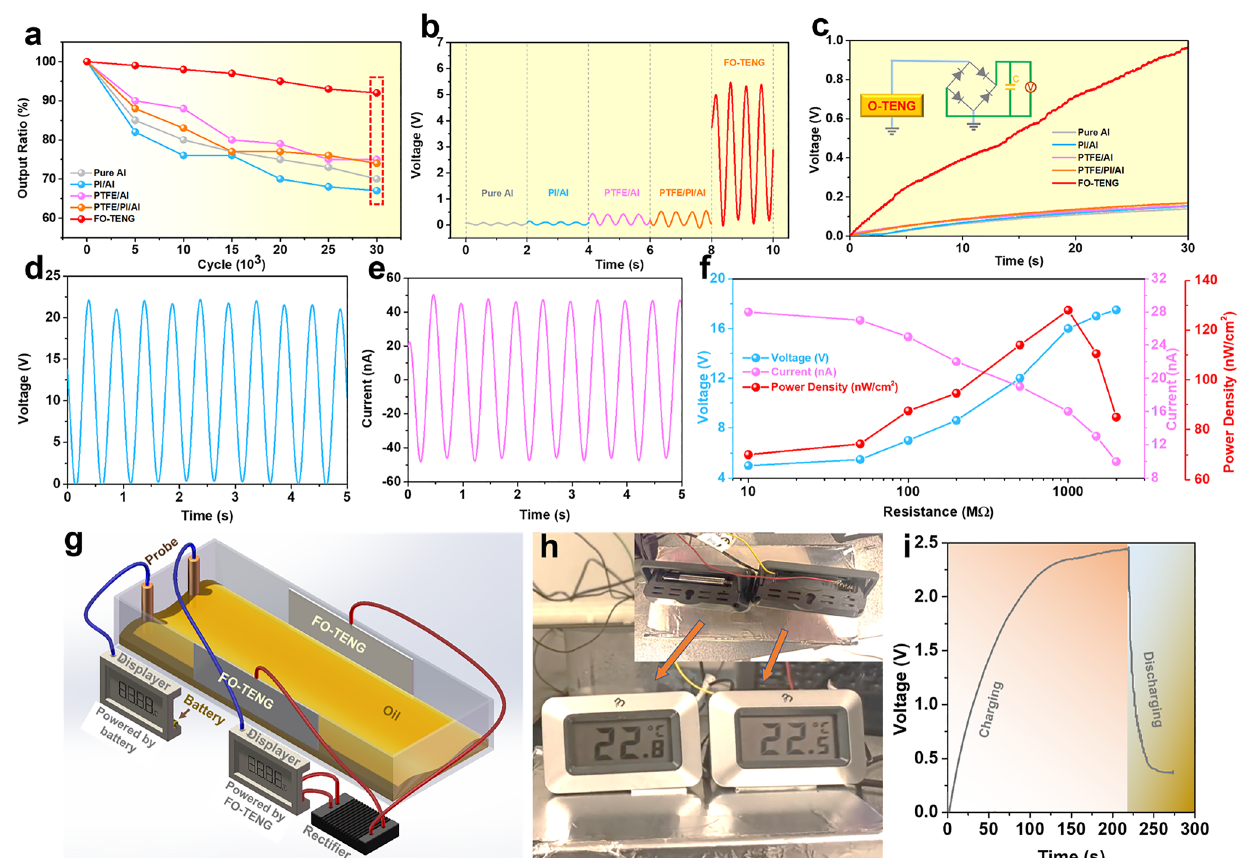
Fig. 3 Durability and energy harvesting of O-TENG. a The long-term durability of the FO-TENG (18–20) for oil-solid contact. b Comparison of voltage output of TENGs. c Voltage accumulated across the capacitors with the capacitances of 4.7 μF, inset: equivalent circuit model of the bridge rectifier to convert the alternating signals. d, e The open-circuit voltage and the short-circuit of the large-sized FO-TENG (Fig. S12) based on double-electrode mode. f The peak current, voltage and power of the large-sized O-TENG with various load resistances. g Two com- mercial monitor displays for real-time and online monitoring of the oil temperature are, respectively, powered by a battery and the large-sized FO-TENG. h Real image of the monitor displays showing the online temperature of oil. i Charging/discharging curve of the large-sized FO- TENG for powering the commercial